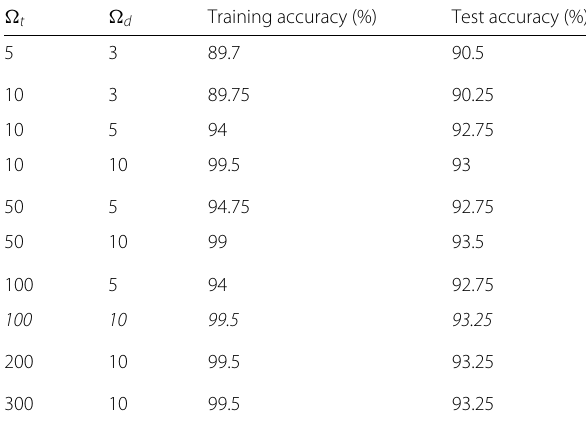
Table 4 Training and test accuracy for different parametrization of random forests